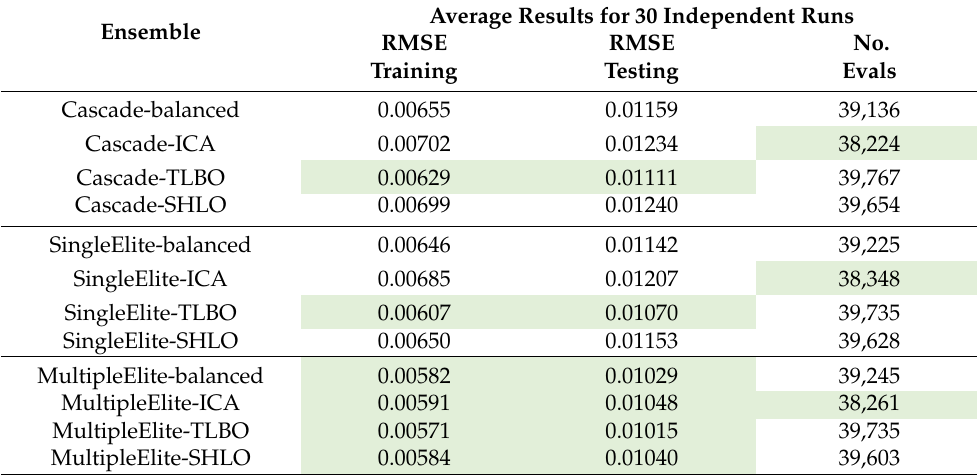
Table 3. Performance of ensembles with a balanced number of iterations and an unbalanced number of iterations for weak